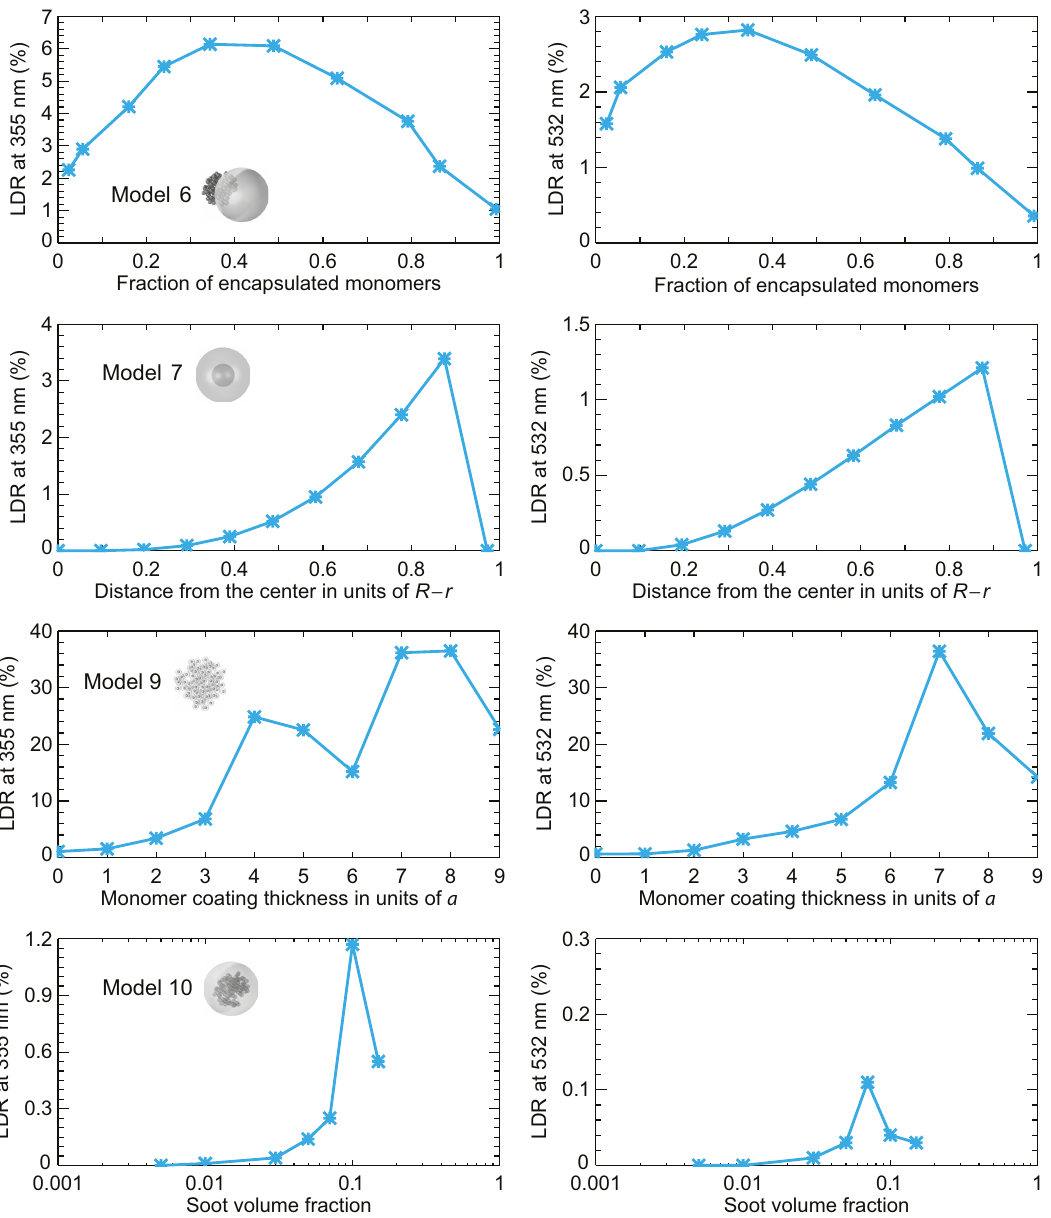
Figure 3. As in Figure 2, but for the linear depolarization ratio (LDR) at λ = 355 nm (left-hand column) and 532 nm (right-hand column).